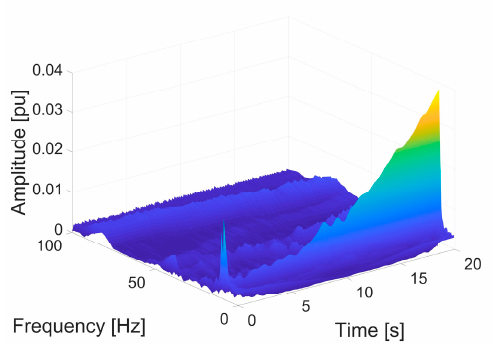
Figure 10. i (cid:48) DC spectrum in the frequency range 0–100 Hz and configuration CA. i ′ spectrum in the frequency Figure 10. DC range (0–100) Hz and configuration CA.